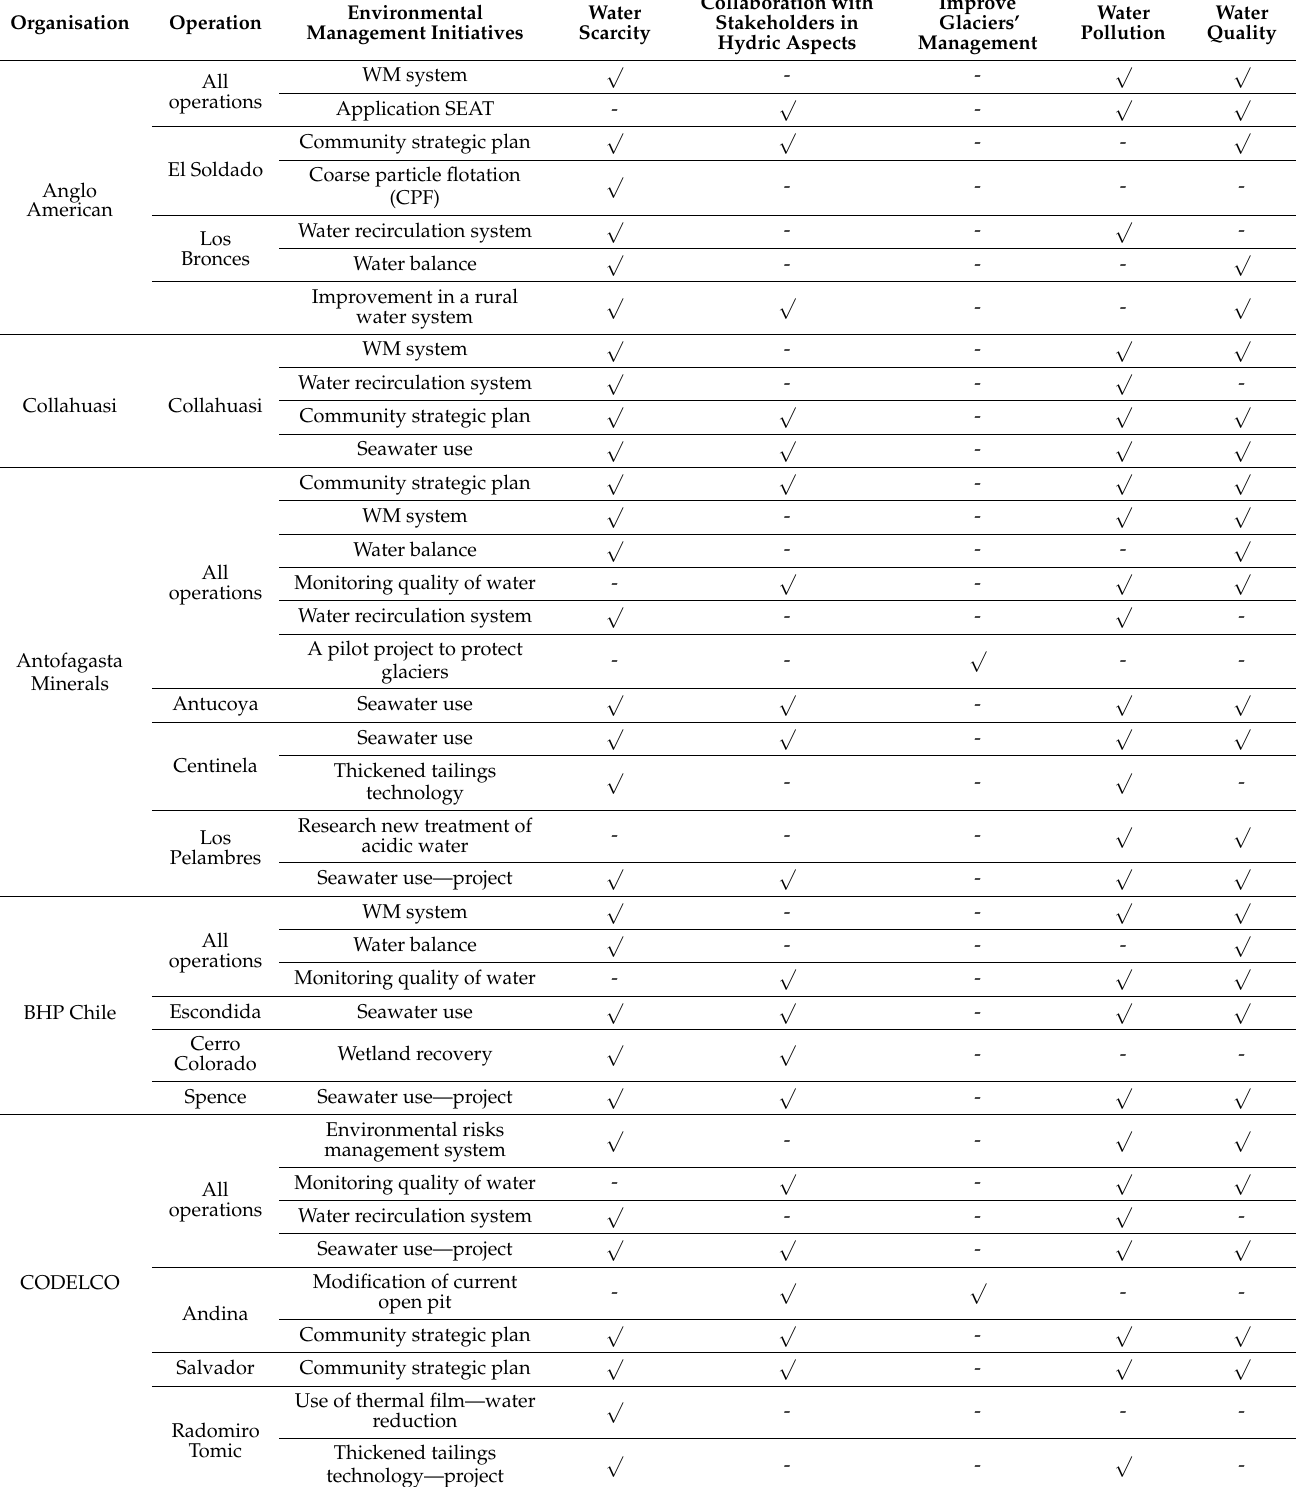
Table 2. Relevant EMIs to deal with water